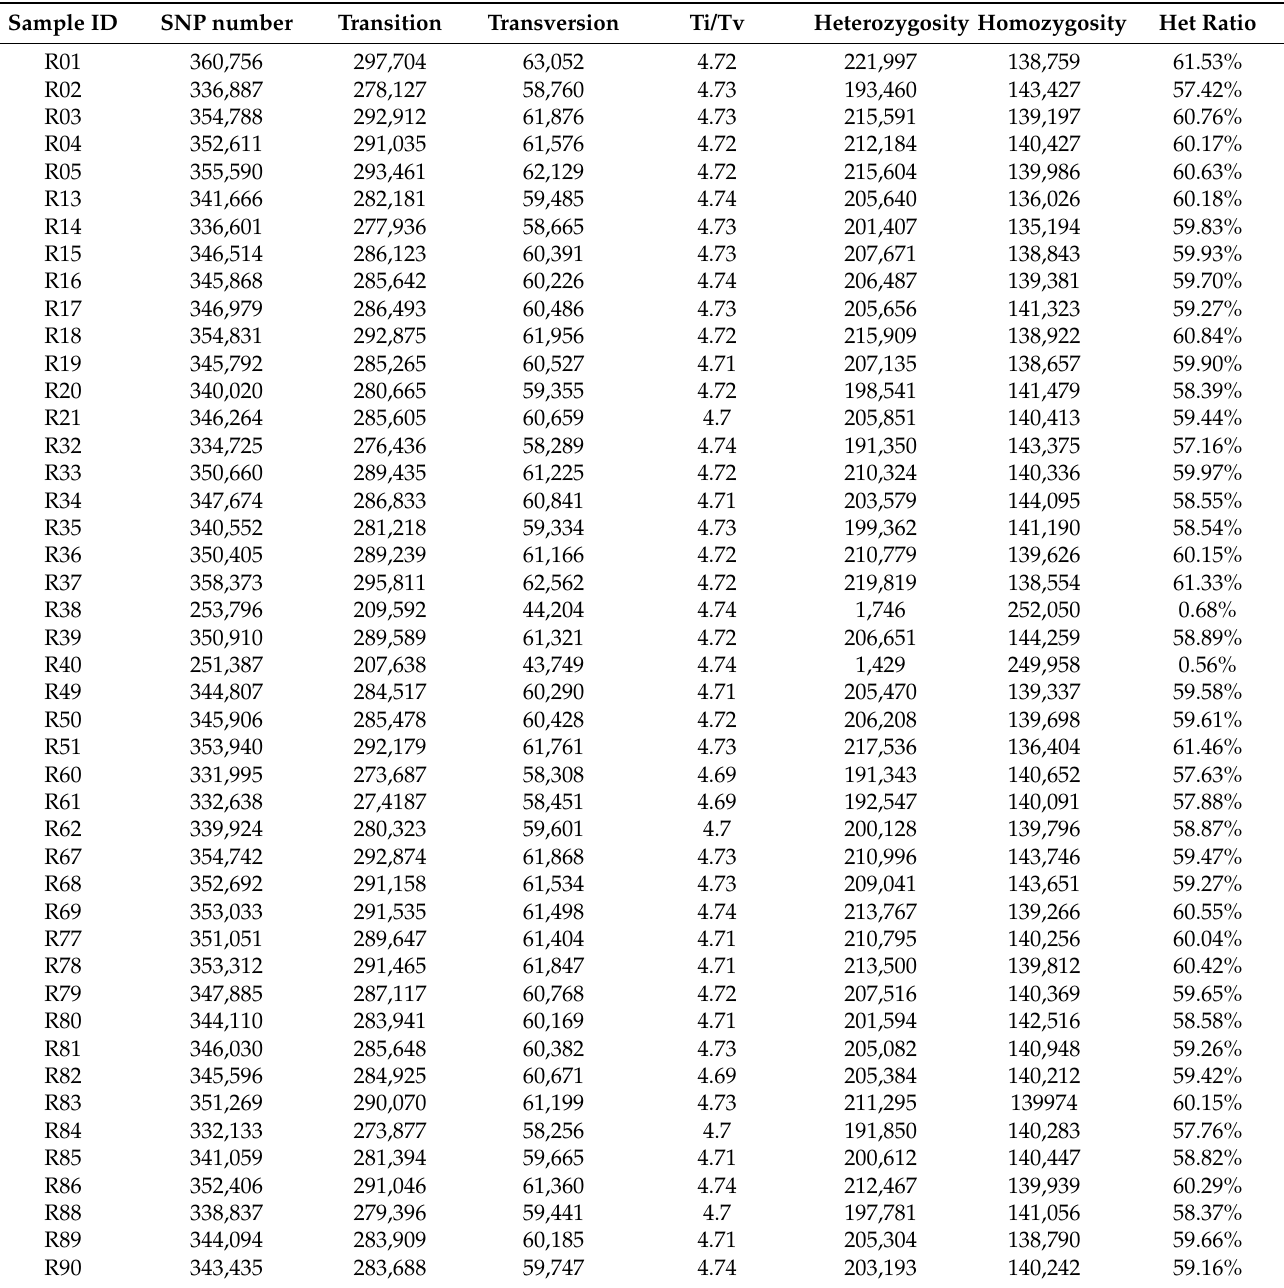
Table A2. The number of SNPs and mutation statistics detected in of 45 susceptible individual samples in A. c. cerana